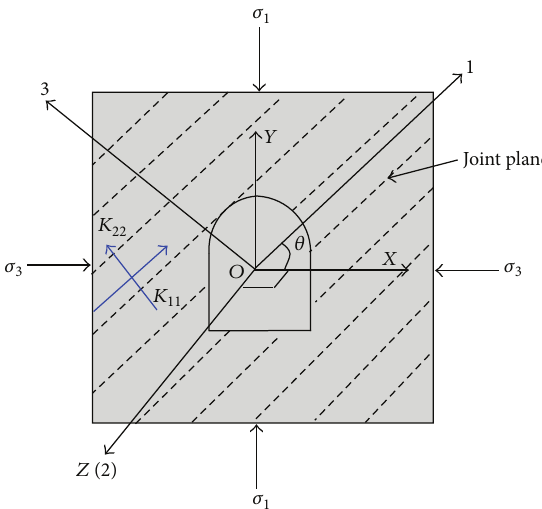
Figure7:Therelationshipbetweenplanesofjointsandtheprincipal stress